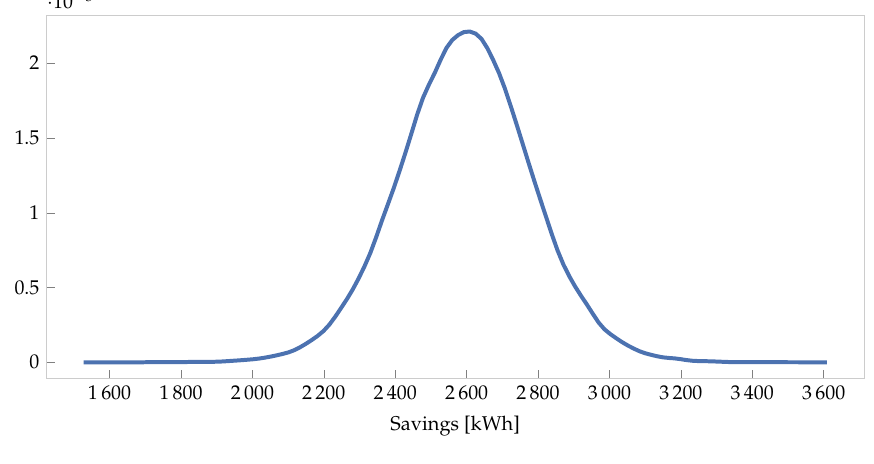
Figure 5. Distribution on the savings for a month with 162 Cooling Degree Days